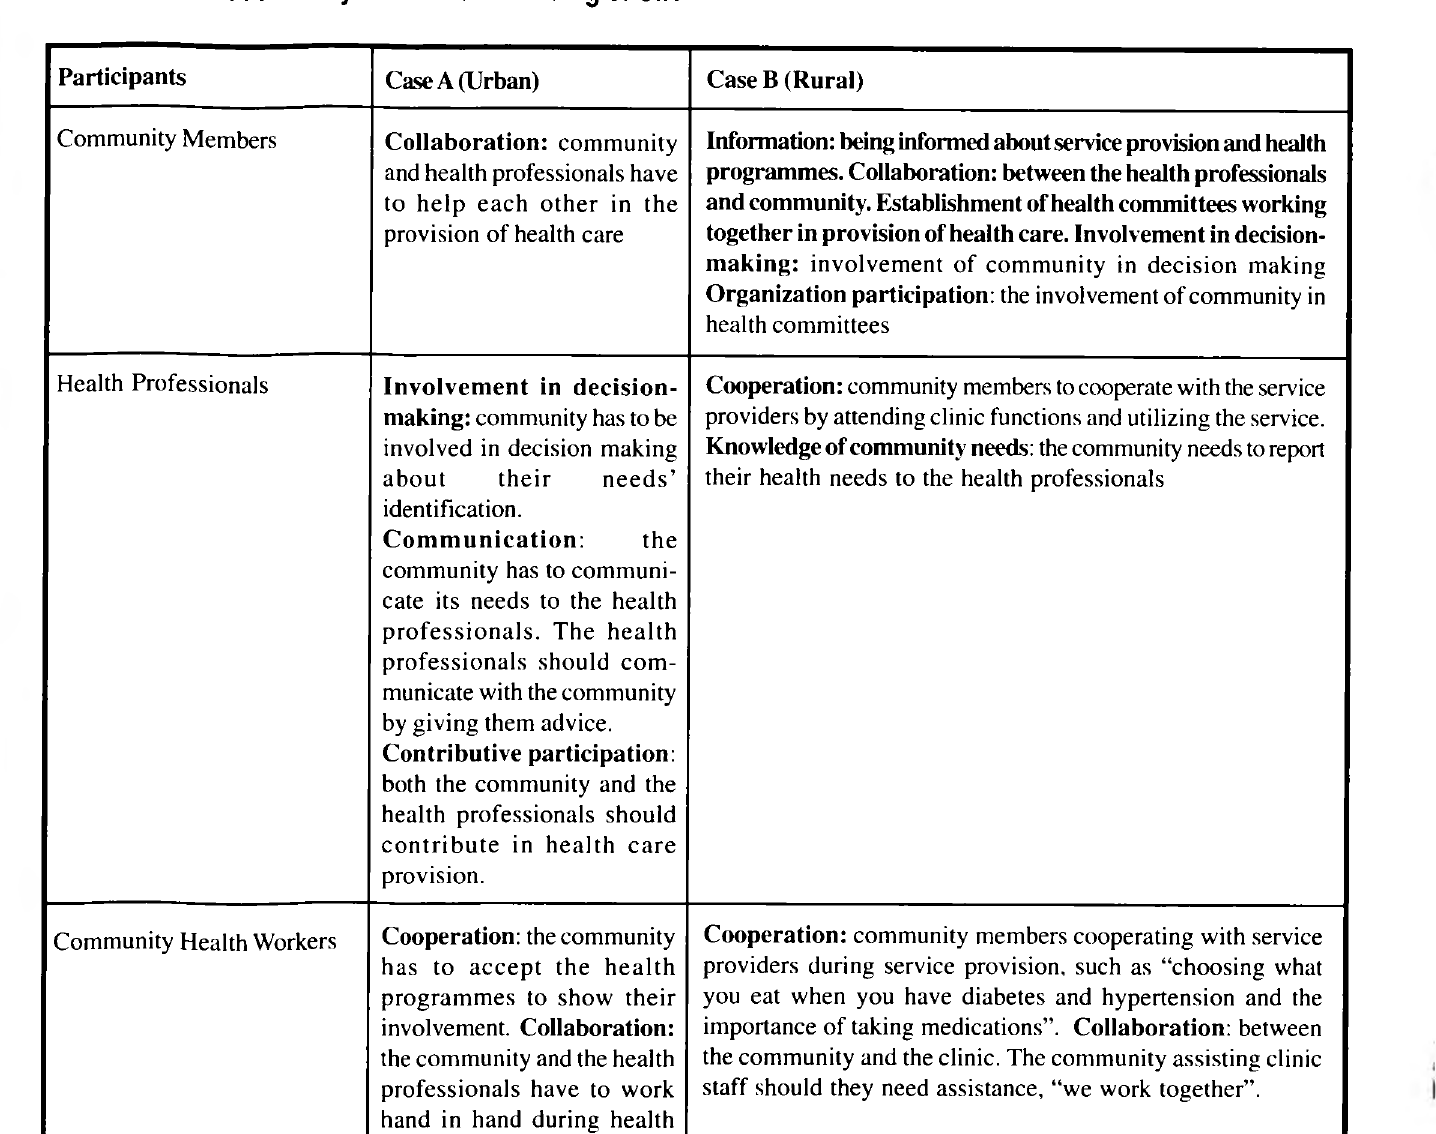
Table: 2 Cross Case analysis of Understanding of CIH